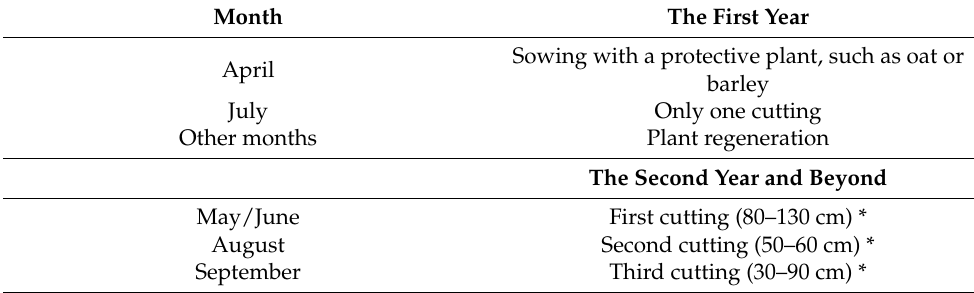
Table 1. Recommended terms of sowing and harvesting for fodder galega [17].